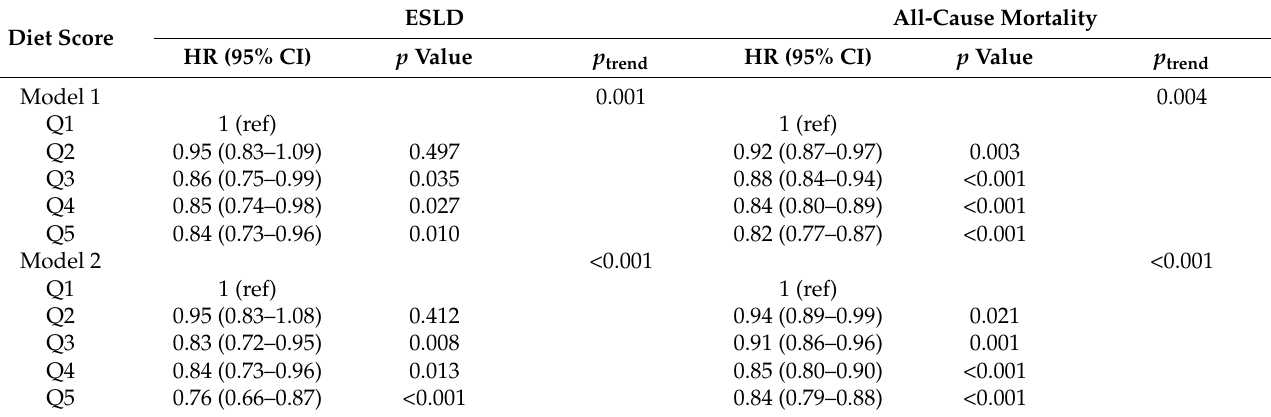
Table 2. HRs of ESLD and all-cause mortality for quintiles of the diet quality